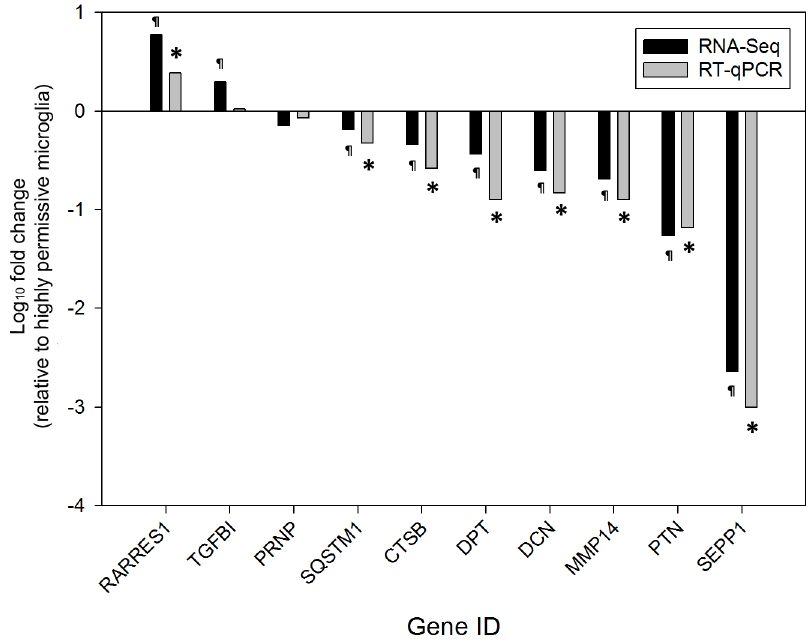
Fig 5. Validation of RNA-Seq results by RT-qPCR. The fold changes in transcription of 10 genes across nine culture replicates of ovine microglia clones inoculated with scrapie prions are shown. Black bars represent RNA-Seq results and gray bars represent RT-qPCR results. RNA-Seq results were confirmed by RT-qPCR in 9 of 10 cases. ¶: P < 0.05. * : P < 0.0001. Gene IDs are on the x — axis. The log 10 fold change in transcription relative to highly permissive microglia is on the y — axis. Thus, positive fold changes indicate upregulation in highly permissive microglia and negative fold changes indicate upregulation in poorly permissive microglia.